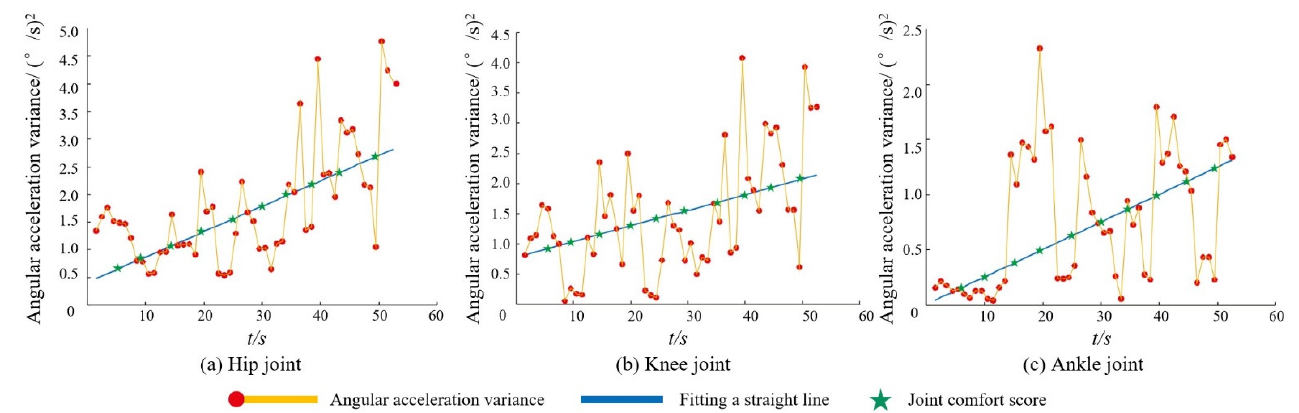
Figure 6. Results of the lower limb joint angular velocity variance comfort index algorithm.